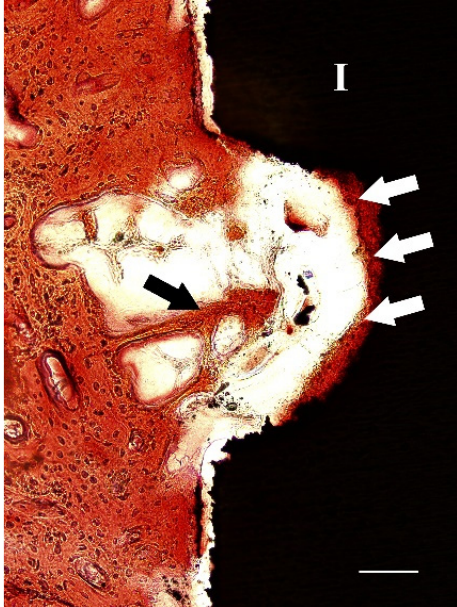
Figure 6. A light micrograph of a section of XiVE ® implant after 4 weeks of implantation with nacre powder, showing an area of mineralized tissue with bone cells (white arrows) attached directly to the implant surface. Trabeculae (black arrow) were found approaching the implant surface; I, implant. Bar = 100 µm. Stevenel’s blue and Alizarin red S stain.